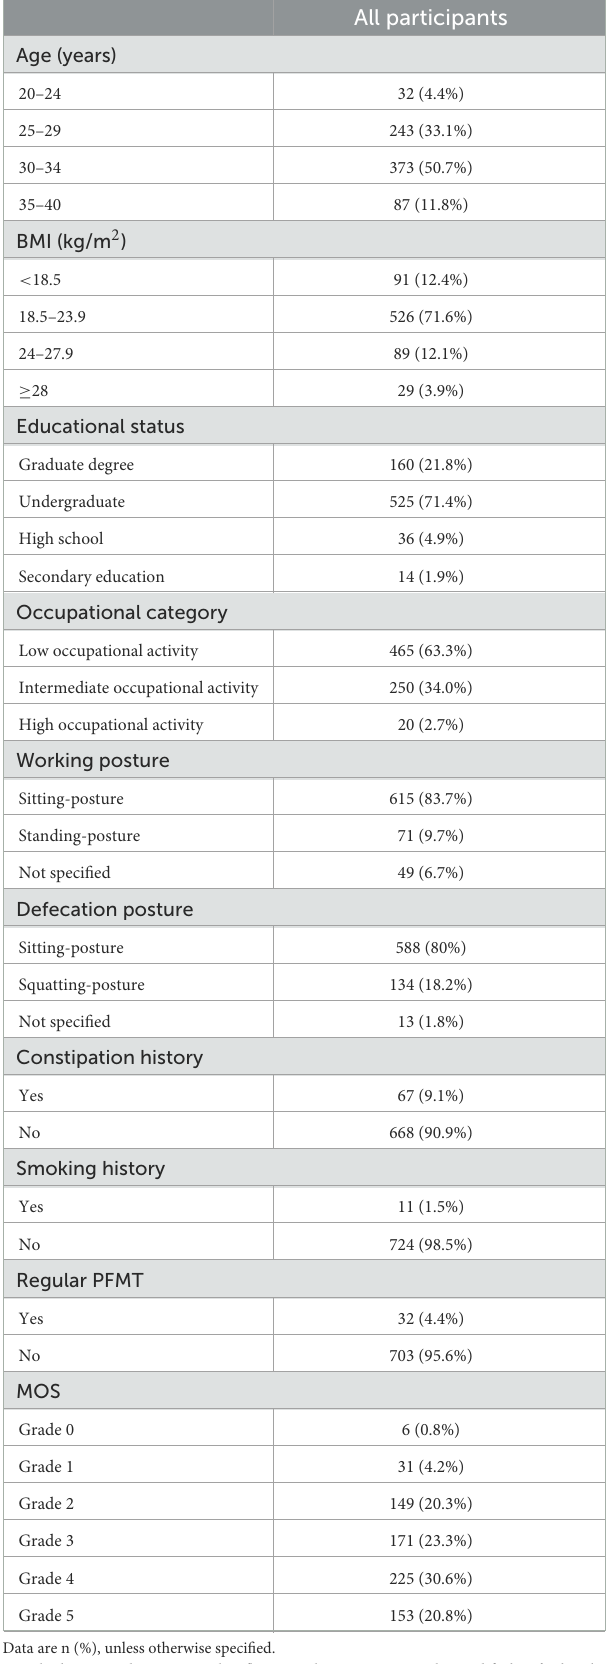
TABLE 1 The demographic data and the MOS distribution for all